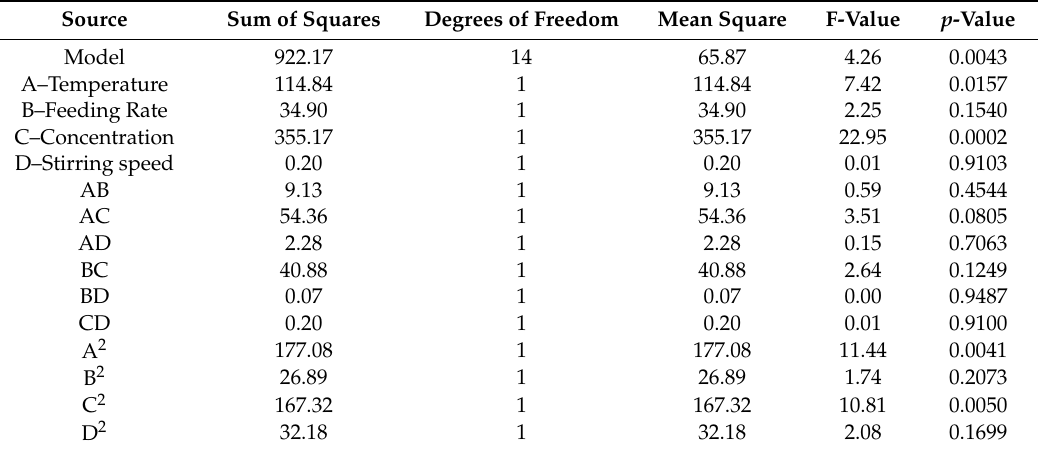
Table 7. ANOVA analysis and results with quadratic model of yield.